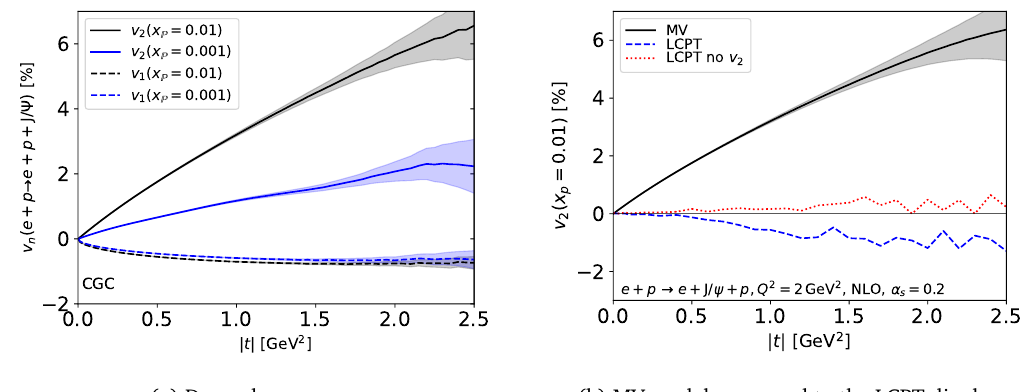
Figure 1: The modulation coefficient v in coherent J /ψ production at Q 2 = 2 GeV 2 n from Ref. [ 5 ] . Left: dependence on the momentum fraction x (cid:80) . Right: v calcu- 2 lated using the dipole amplitude from the impact parameter dependent MV model (standard setup) and from the LCPT calculation of Ref [ 12 ]